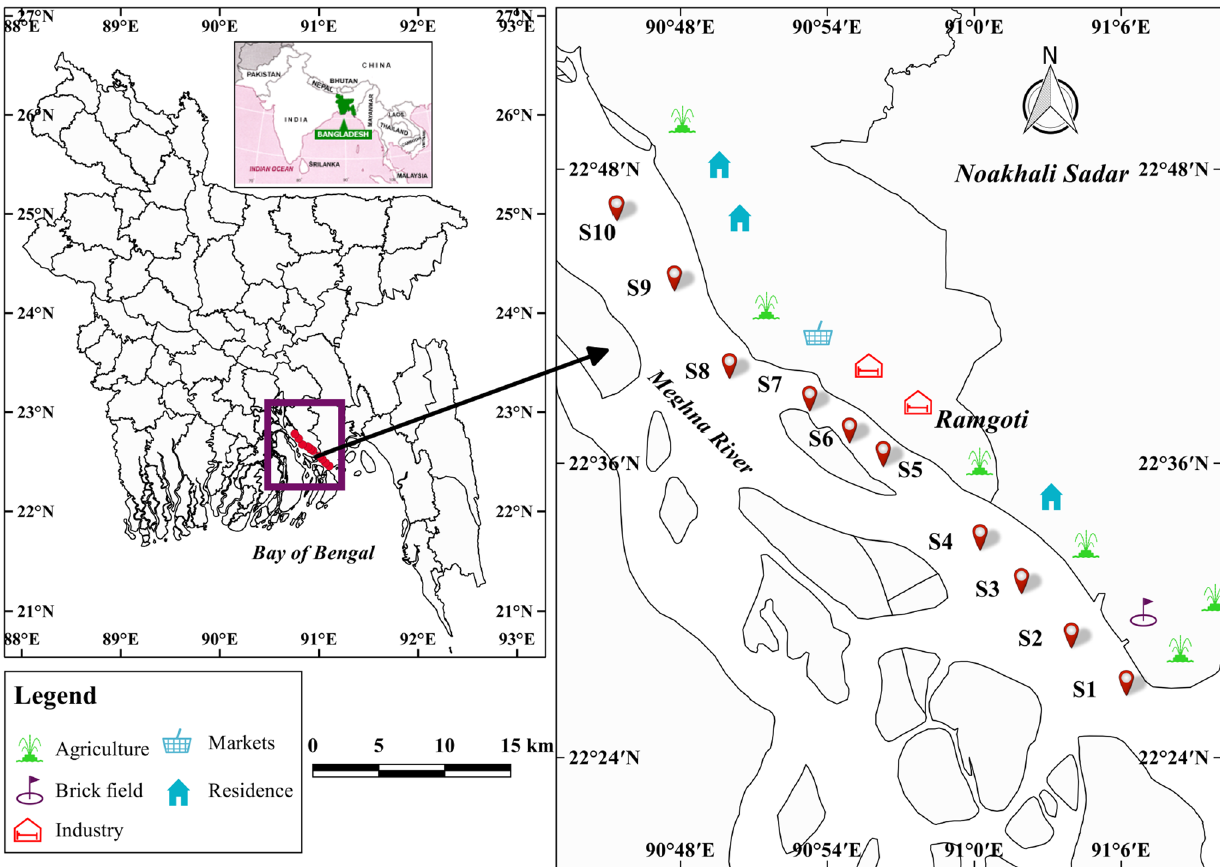
Fig. 1 Sampling sites along the Meghna River estuary, near the Bay of Bengal in Noakhali District,